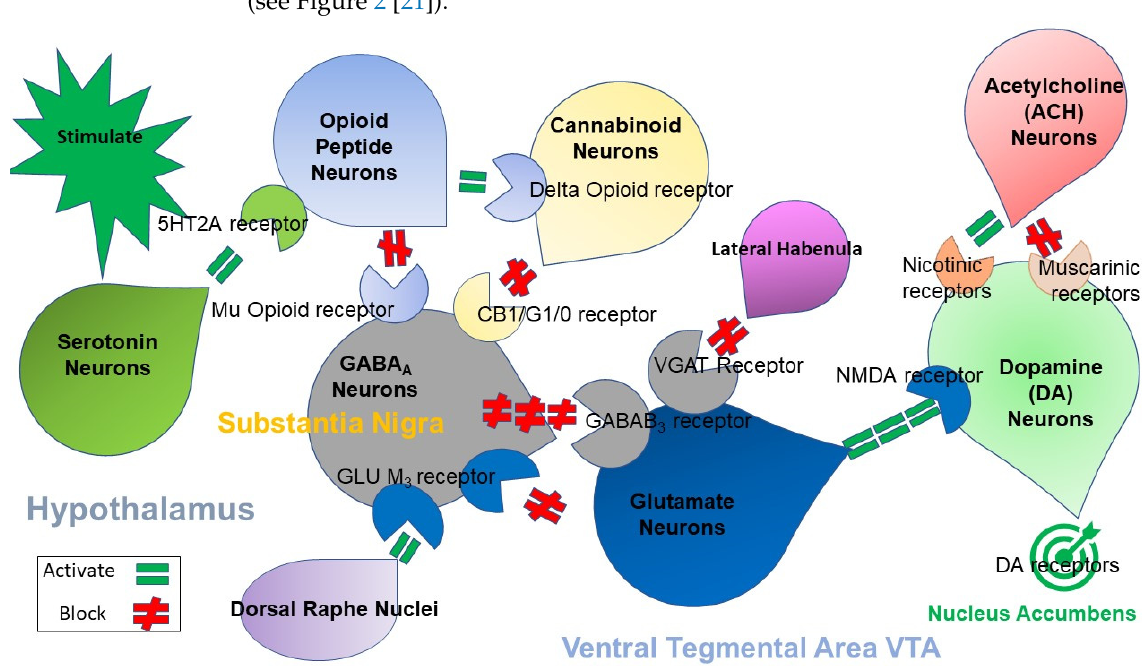
Figure 2. The Brain Reward Cascade.